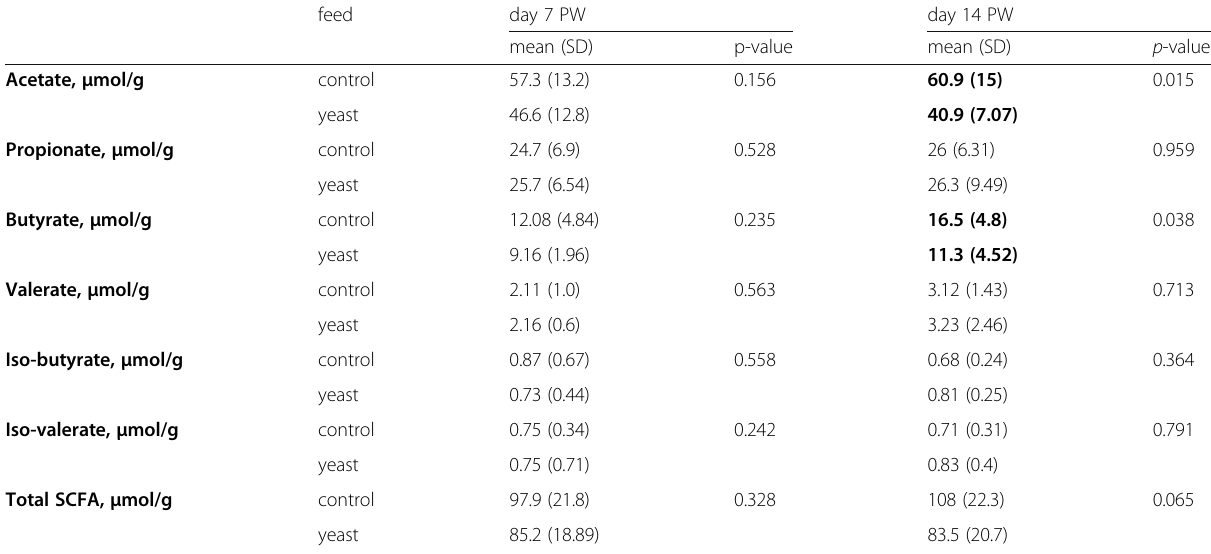
Table 2 Colonic SCFA concentration comparison between the control and the yeast group. The concentration values are reported as μ mol/g of colon digesta. Comparison pairs that correspond to p-values less than 0.05 (MWW test) are given in